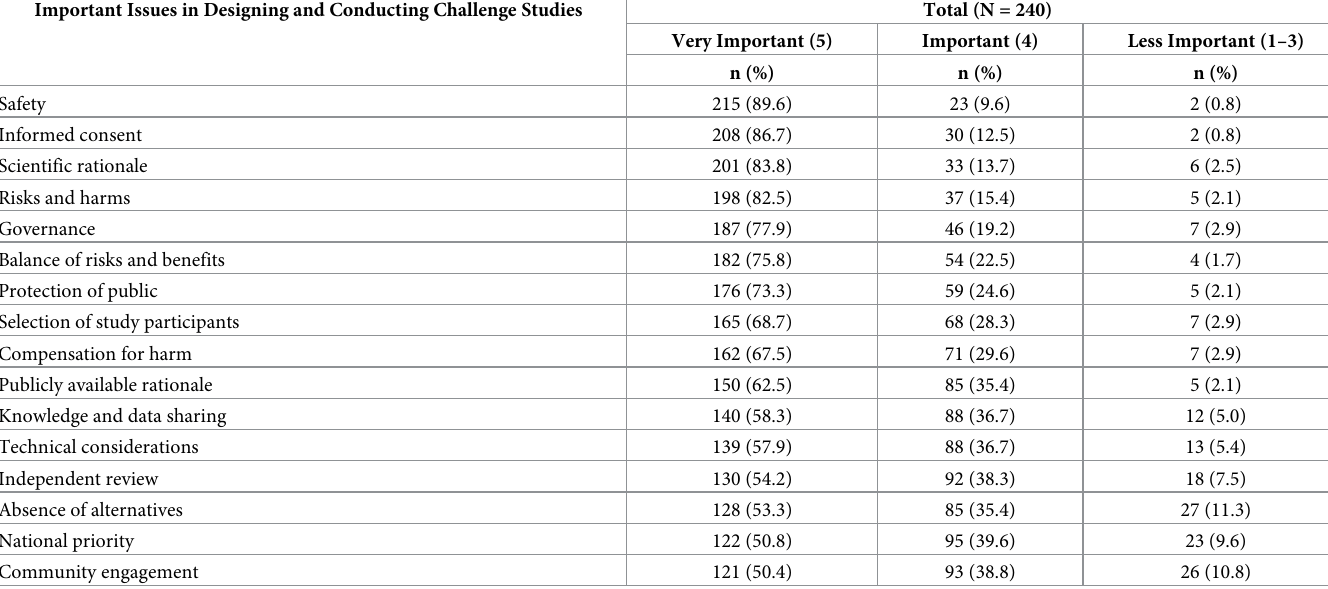
Table 2. Ratings of important issues in designing and conducting challenge studies (N =